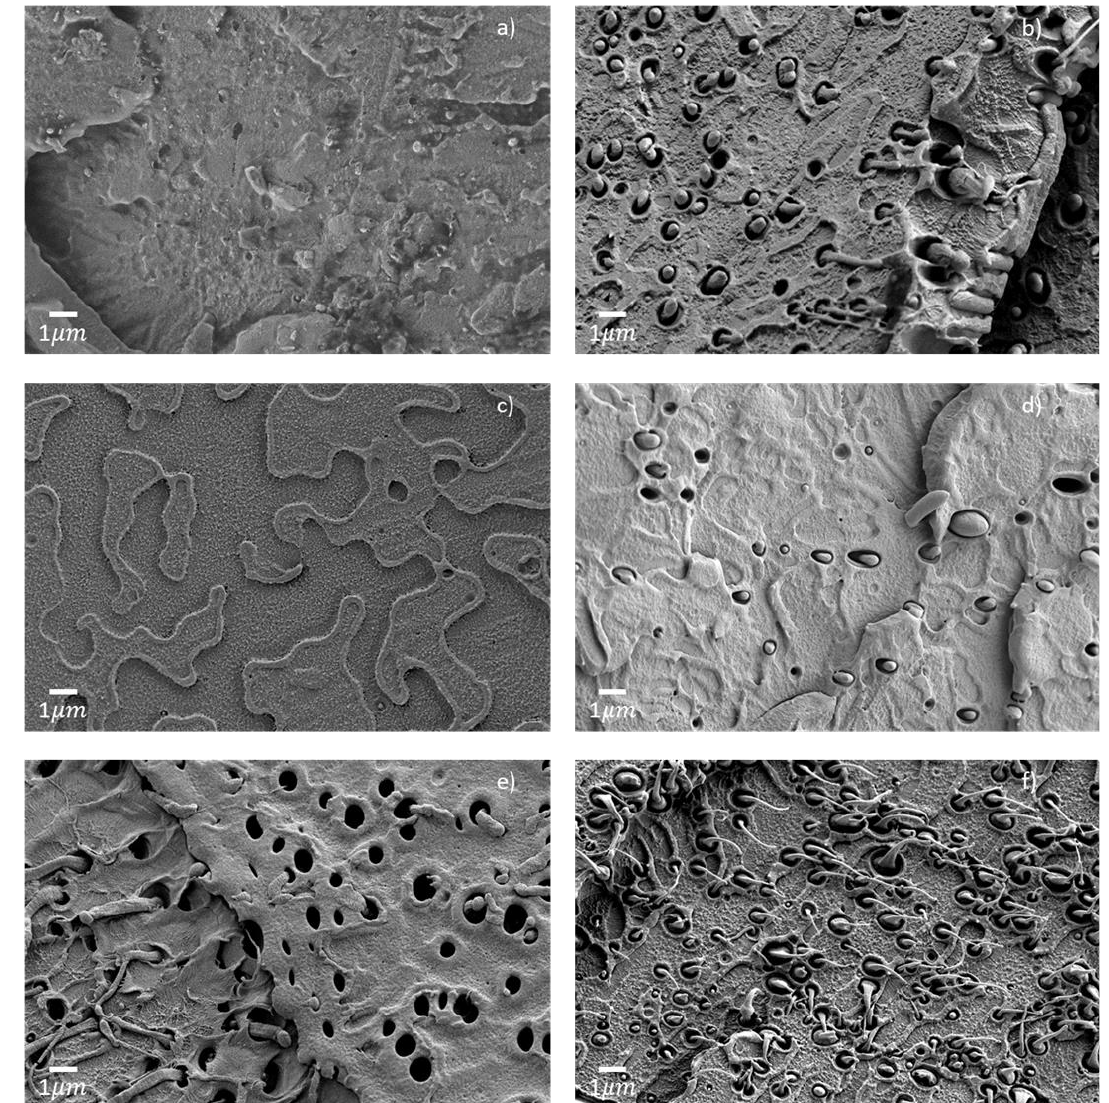
Figure 5. Electron micrographs of single prints ( a ) P-PET0, ( b ) P-PET5 and three prints, ( c ) P-PET0,